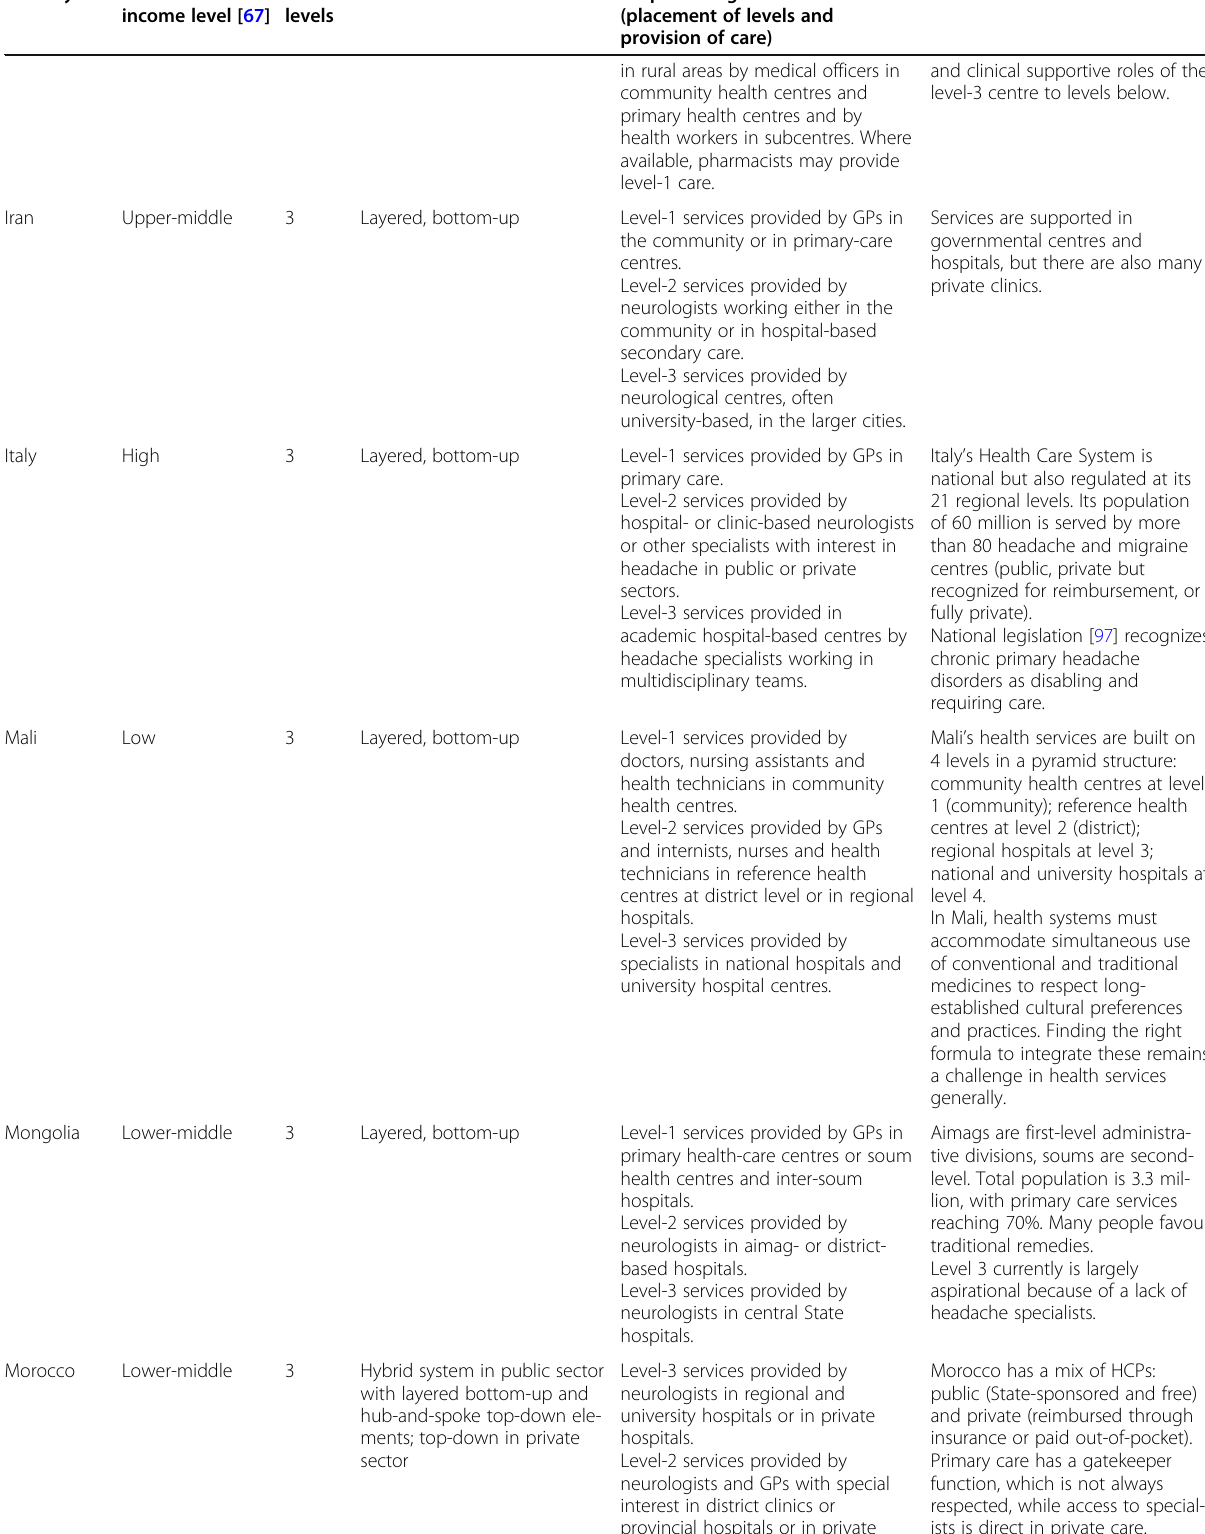
Table 7 Illustrations of how the model might be implemented, with adaptations, in various countries